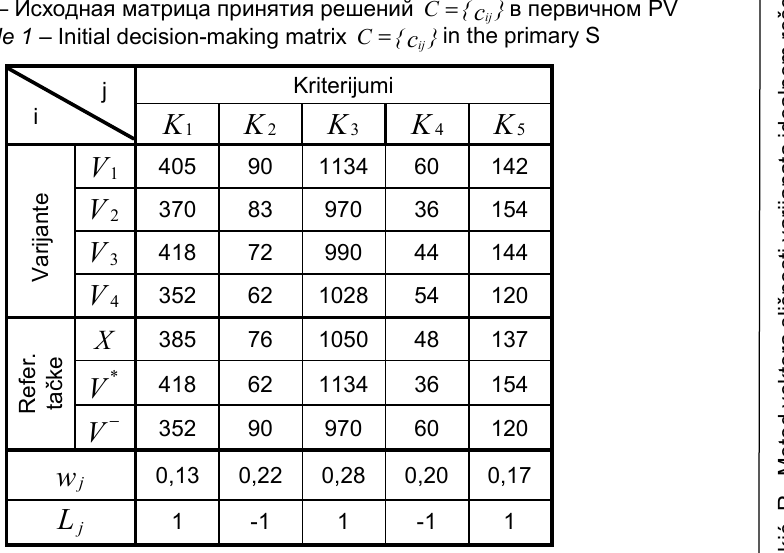
Table 1 – Initial decision-making matrix }{C c